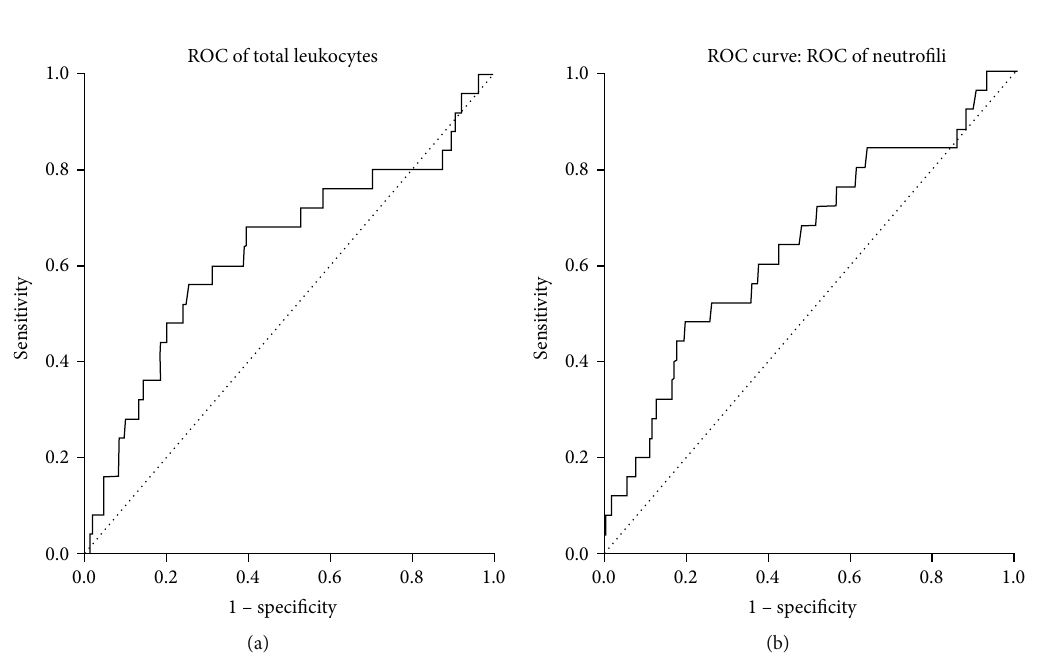
Figure 1: ROC curve analysis and area under the curve (AUC) calculation showing the diagnostic accuracy of total leukocyte and neutrophil ’ s count at discharge to identify subjects at risk of developing surgical site infection (SSI). The AUC values are equal to 0.623 ( p = 0 : 025 ) and 0.641 ( p = 0 : 016 ),